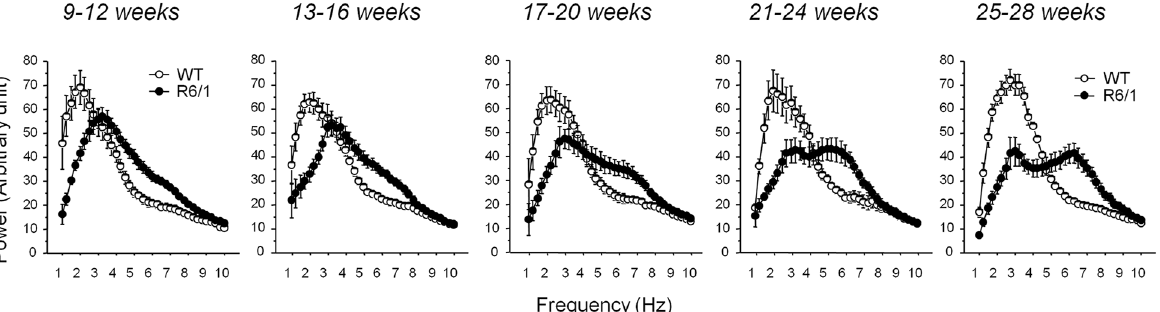
Fig 4. Spectral power for 1-10Hz averaged by genotype during SWS (slow wave sleep) at different ages in both genotypes. AU: Arbitrary